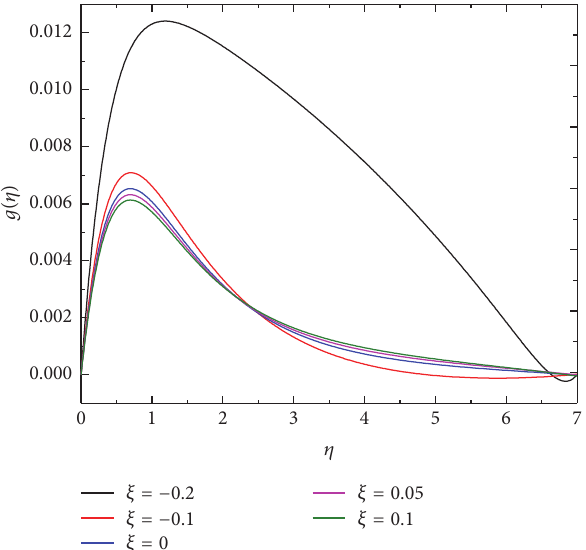
Figure 11: Temperature profiles for various values of 𝐴 when 𝐾 = 0.2 , 𝑅 = 0.5 , and 𝜉 = 0 .